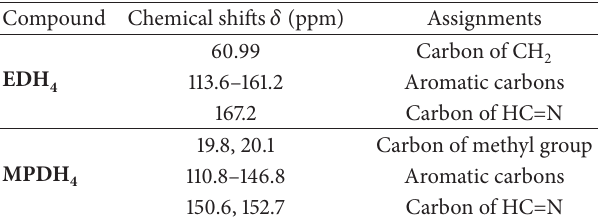
Table 4: Chemical shifts (ppm) for 13 C NMR of Schiff bases EDH and MPDH in 4